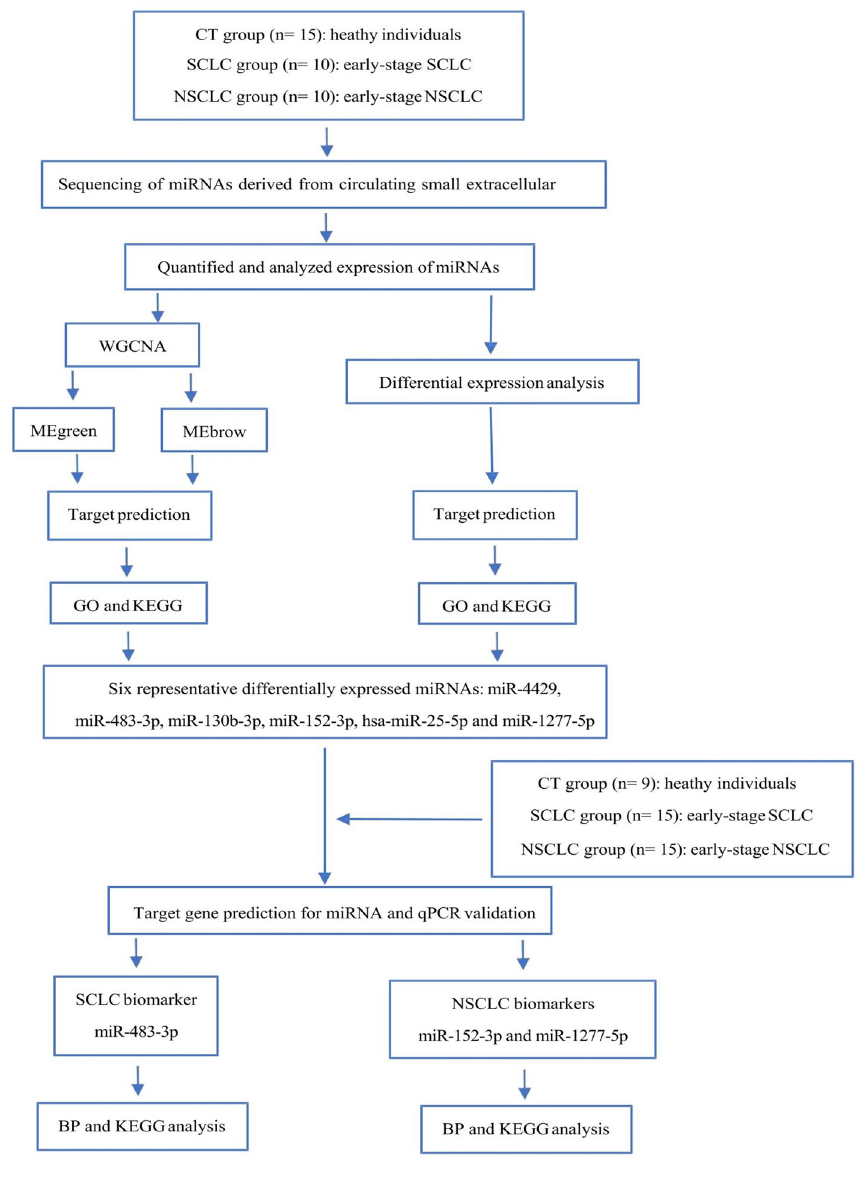
Figure 1. Flow chart of the